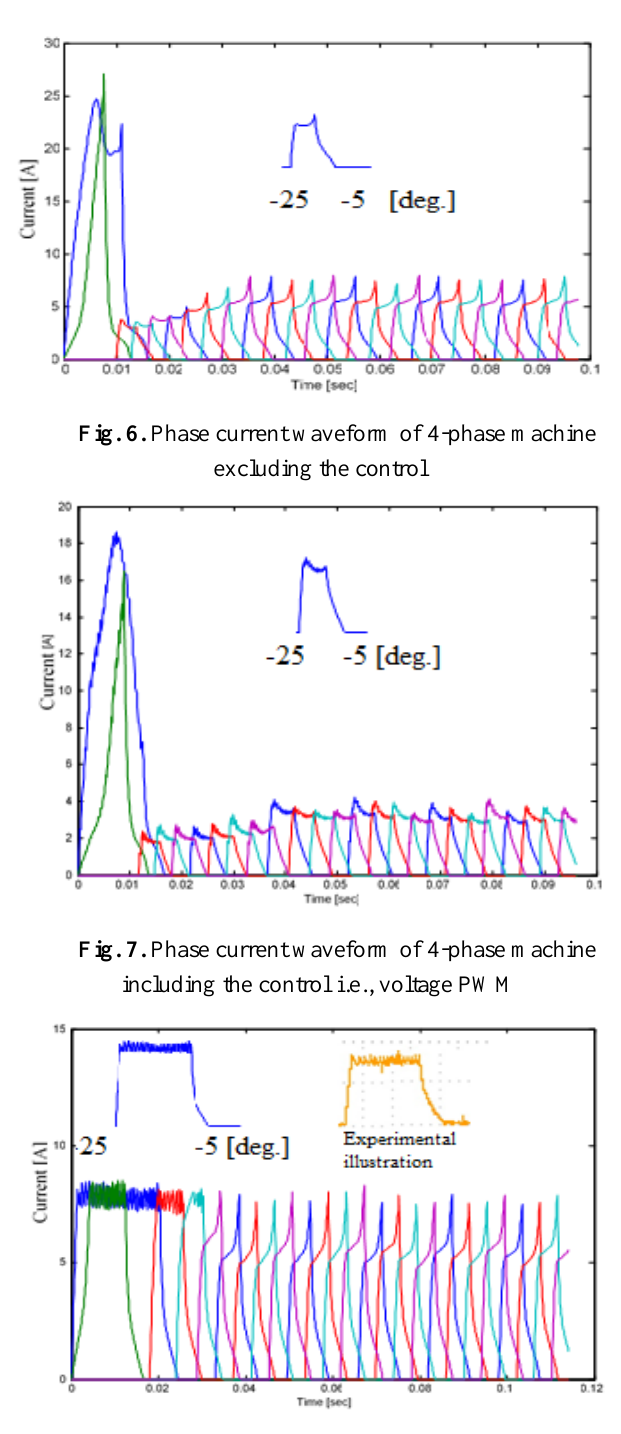
Fig. 8(a). Phase current waveform of 4-phase